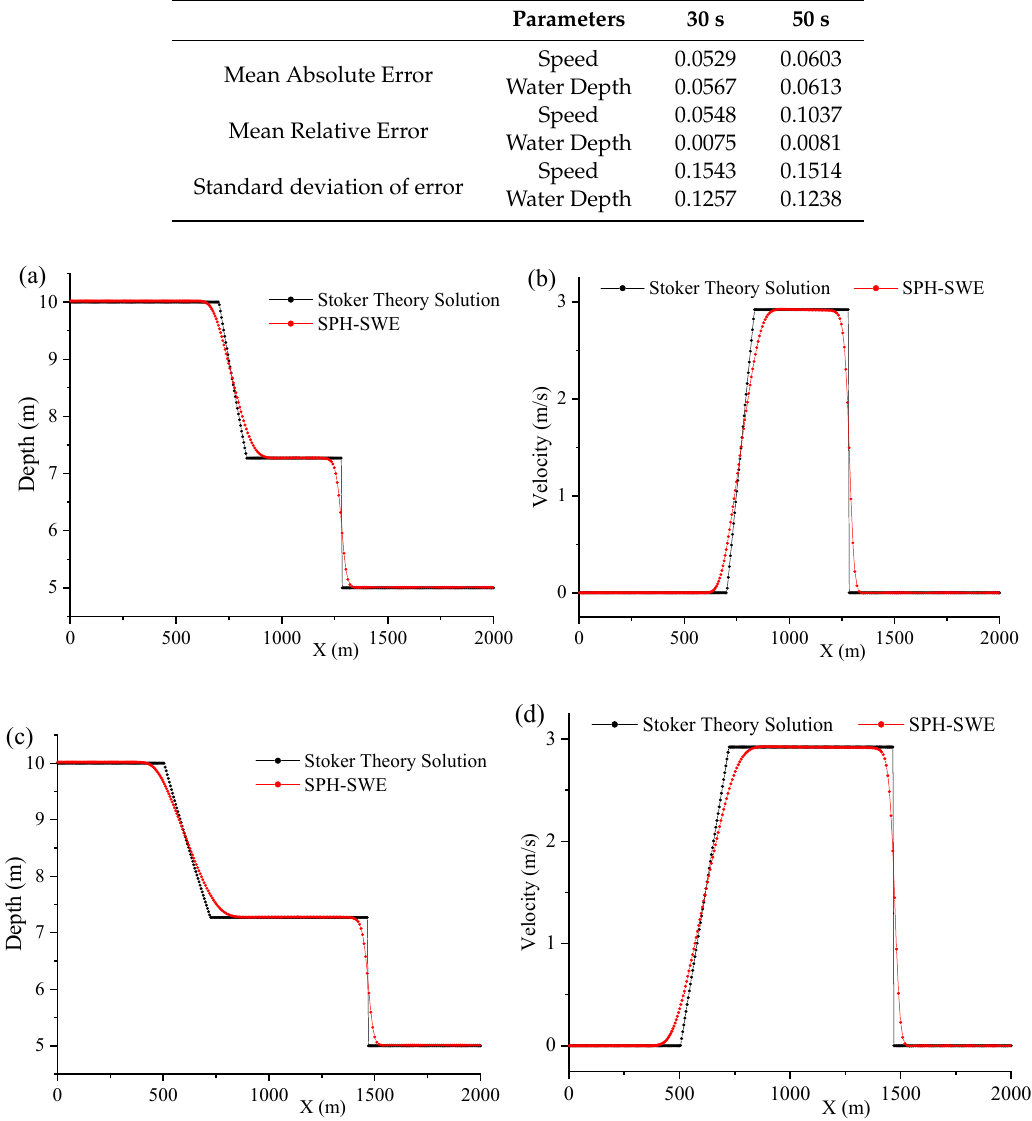
Figure 4. Simulation results of the SPH-SWE module. ( a , b ) water depth and velocity diagram at t = 30 s; ( c , d ) water depth and velocity diagram at t = 50 s.